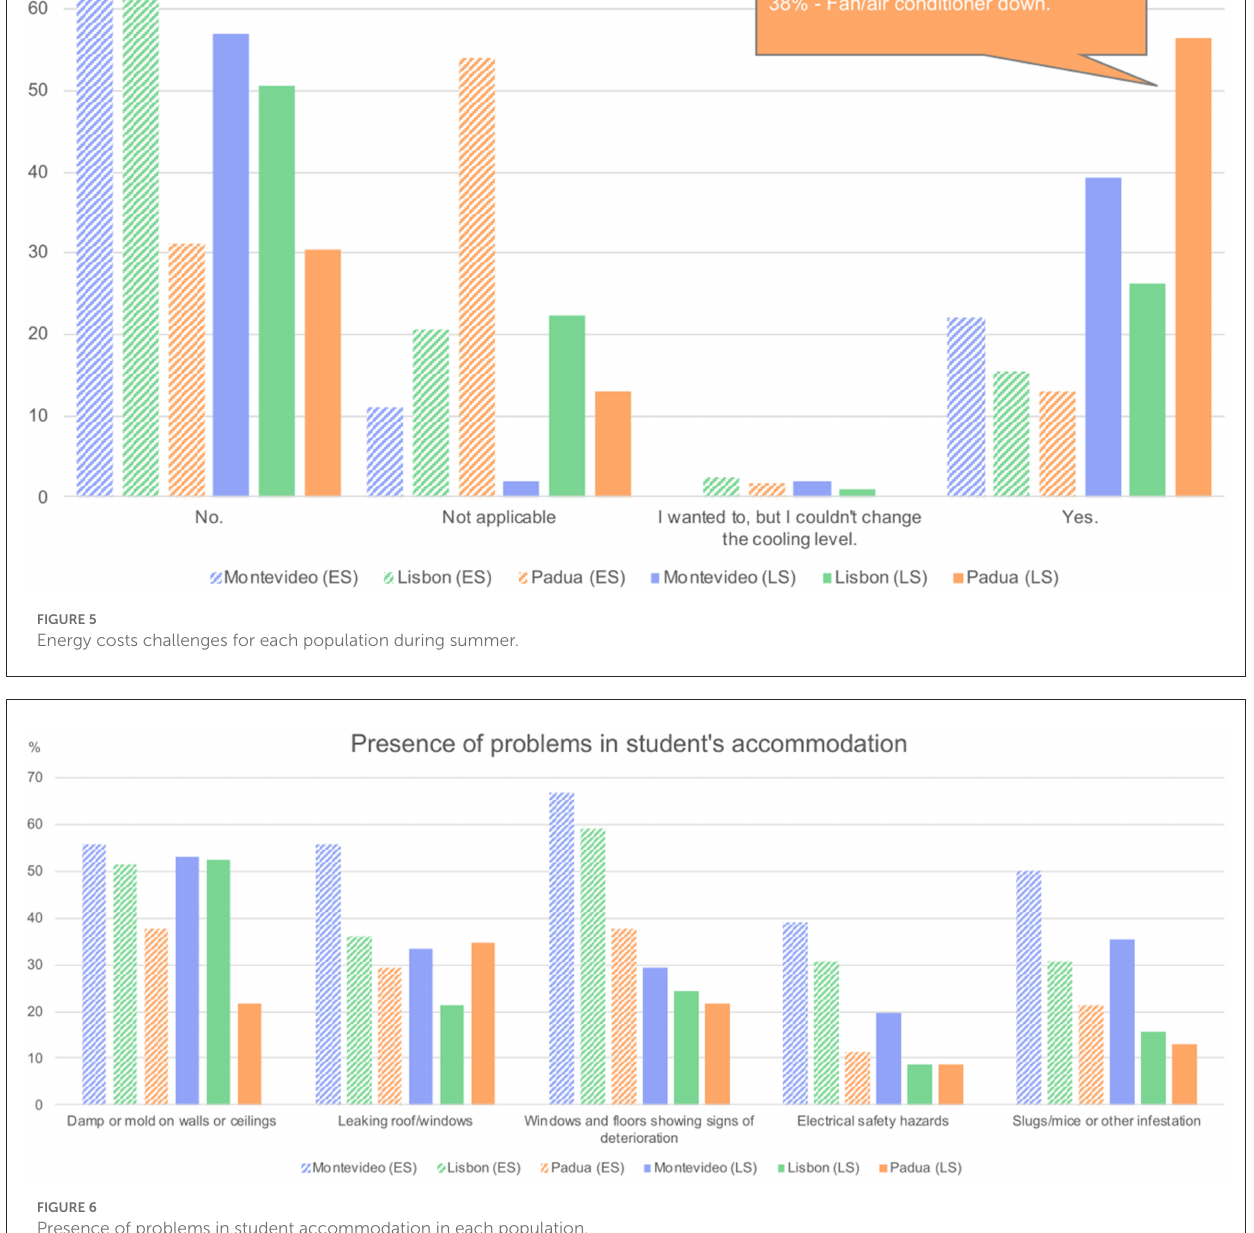
conditions affected them, the most frequent way they were affected was “It made me feel